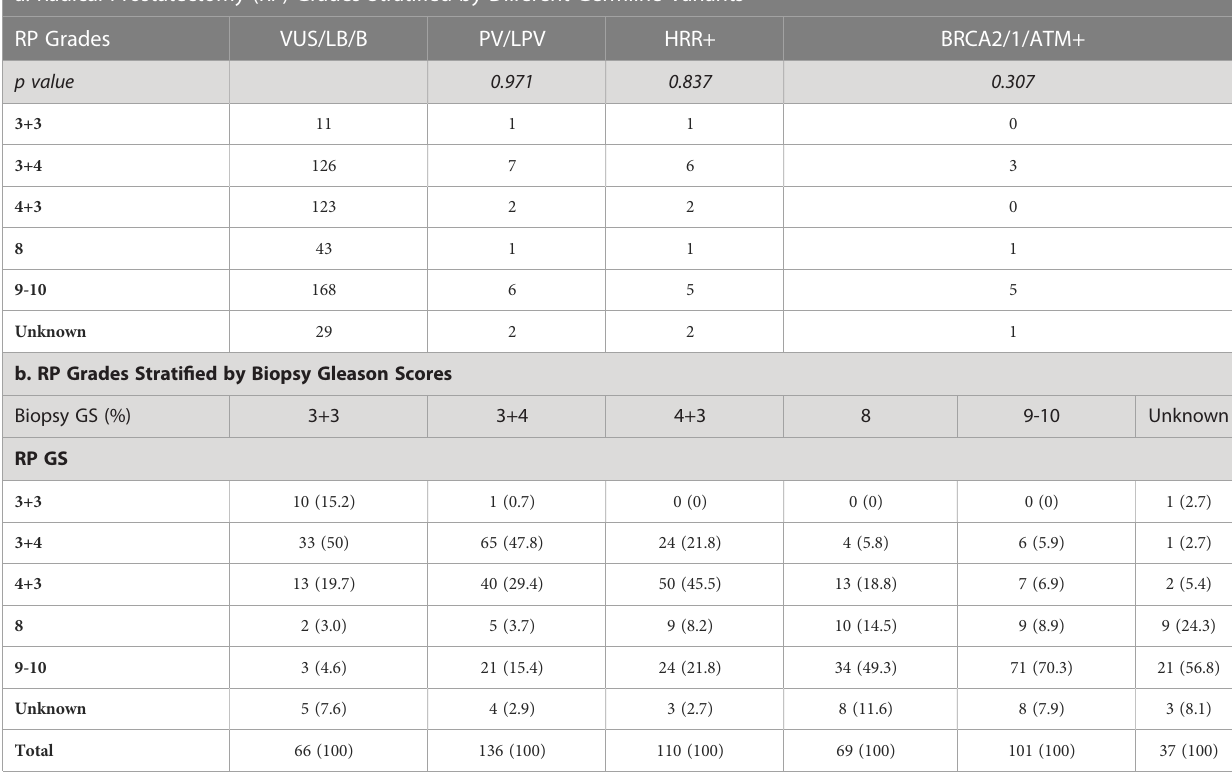
TABLE 4 Germline tested patients underwent radical prostatectomy (n=519).